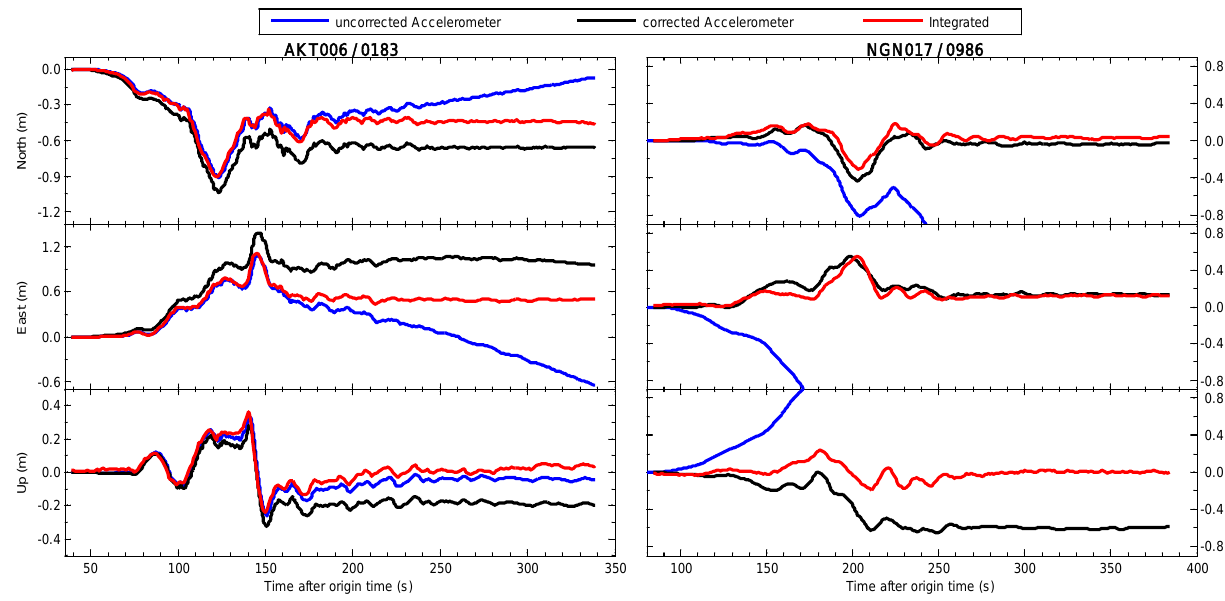
Figure 1. Comparison of uncorrected seismic-only and corrected seismic-only, and integrated displacements on the collocated AKT006 (seismic) and 0183 (GPS) pair and NGN017 (seismic) and 0986 (GPS) pair during the Tohoku-Oki earthquake on 11 March 2011. All sub-figures show the entire period of seismic shaking. The 100 Hz integrated displacement is shown by the red line. The 100 Hz seismic-only displacements without baseline correction and with baseline correction are respectively shown by the blue line and the black line,